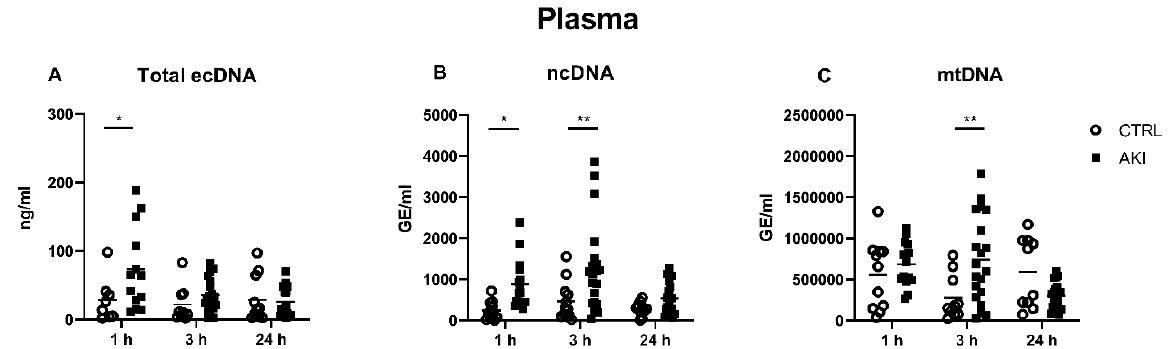
Figure 2. Concentrations of plasma total ecDNA ( A ), ncDNA ( B ) and mtDNA ( C ) at different time points after AKI induction. CTRL—control group; AKI—glycerol-induced acute kidney injury. * denotes p < 0.05. ** denotes p < 0.01.